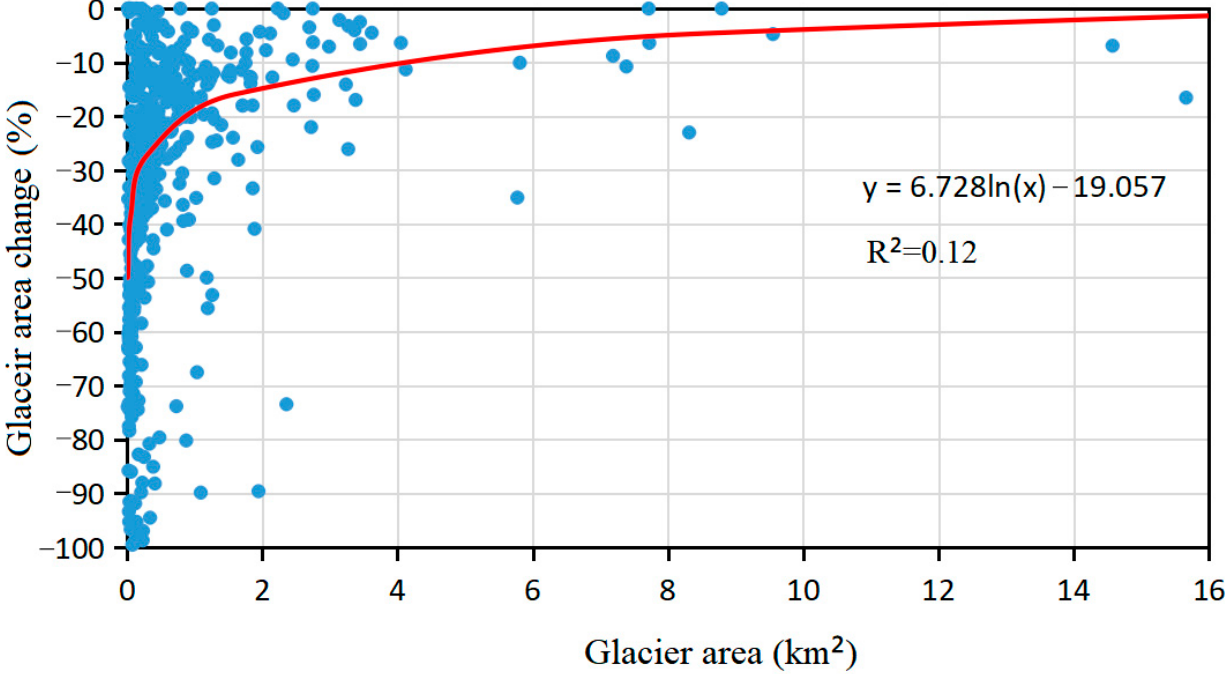
Figure 5. Changes in glacier number ( a ) and area ( b ) in the northern Tien Shan from 1990 to 2015.